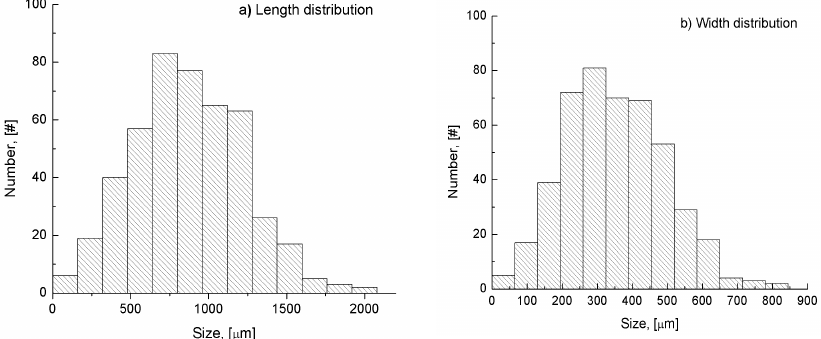
Figure 5. Crystal habits of L-lactide. The CSD of the seed crystals according to the characteristic dimension is plotted in Figure 6a in which the sizes of seeds range from about 10 to 2000 µm (a mean value of 871.2 µm). The relatively wide range of this distribution is explained based on the directly harvesting step from the recrystallization without any further preparation, such as milling or sieving.